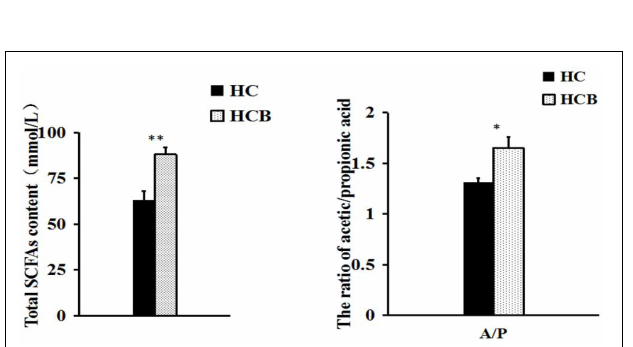
FIGURE 1 | Effect of sodium butyrate on the content of SCFAs in the cecum of lactating goats. The SCFA levels are indicated on the ordinate axis (mean ± SEM). Significant differences between HC and HCB groups are represented by ∗ P < 0.050 or ∗∗ P < 0.010.